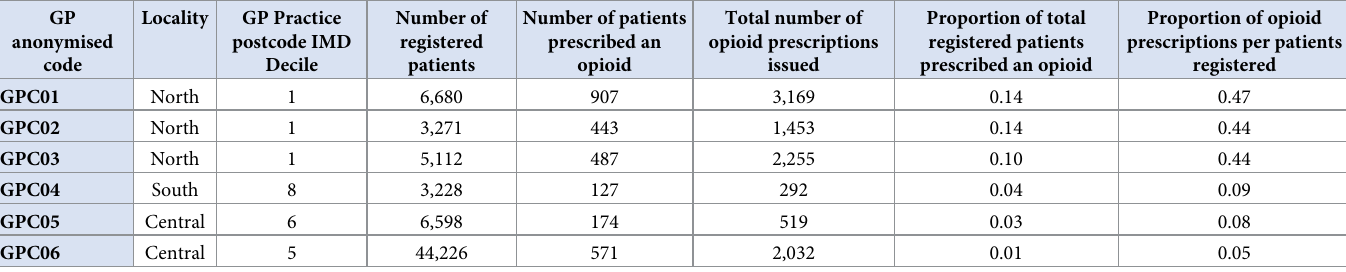
Table 3. Proportion of patients prescribed opioids at lowest vs. highest prescribing surgeries. GP anonymised